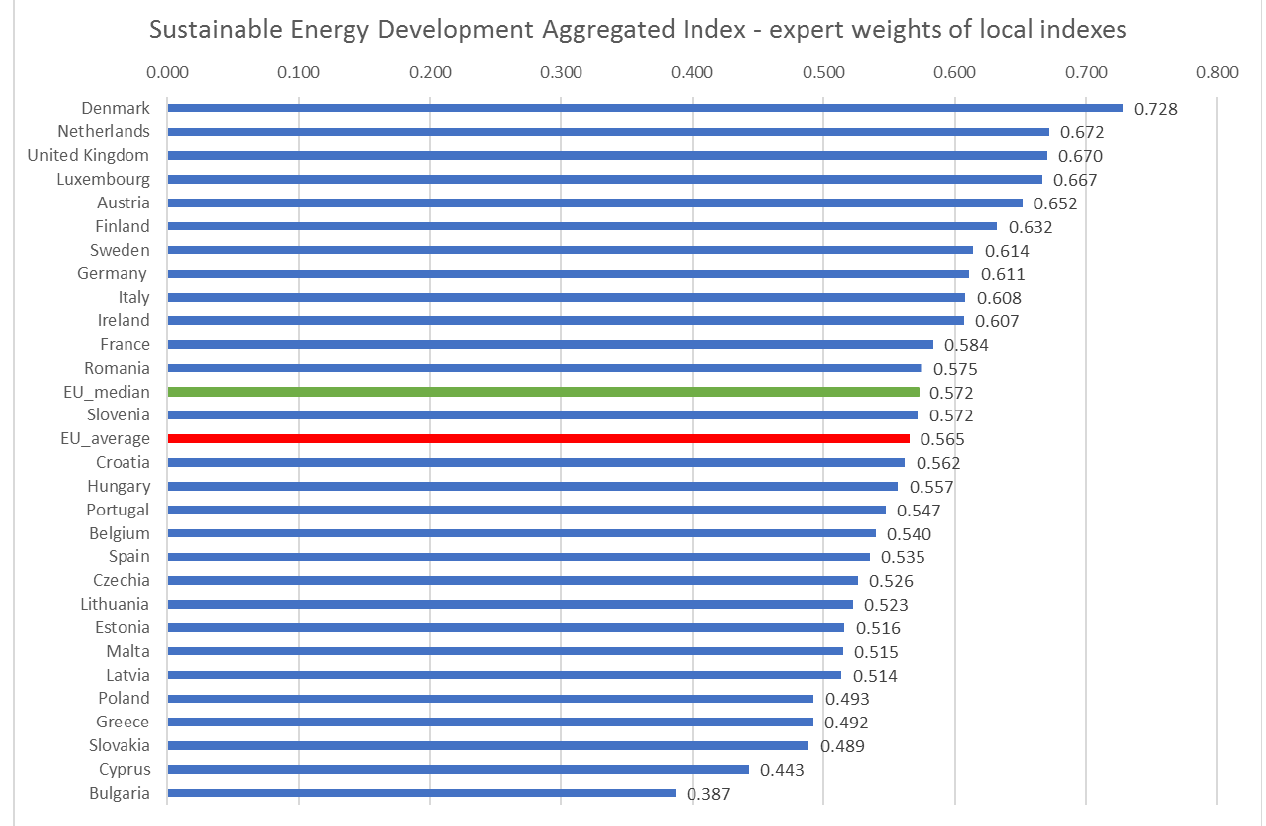
Figure 6. SEDAI in 2017 for the EU-28 Member States calculated with the use of expert weights of dimensions.